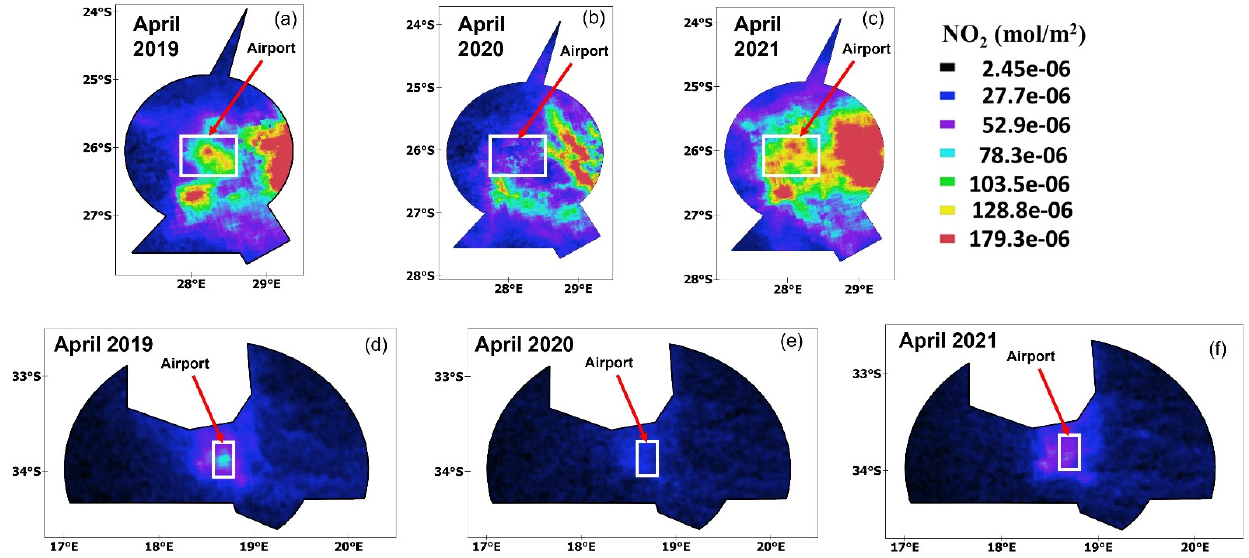
Figure 5. NO 2 tropospheric column and distribution for April ( a ) before the Level-5 lockdown over OR Tambo International Airport (FAOR), ( b ) during the lockdown Level-5 over FAOR, and ( c ) after the Level-5 lockdown over FAOR; ( d ) before the Level-5 lockdown over Cape Town International Airport (FACT), ( e ) during the lockdown Level-5 over FACT, and ( f ) after the Level-5 lockdown over FACT.